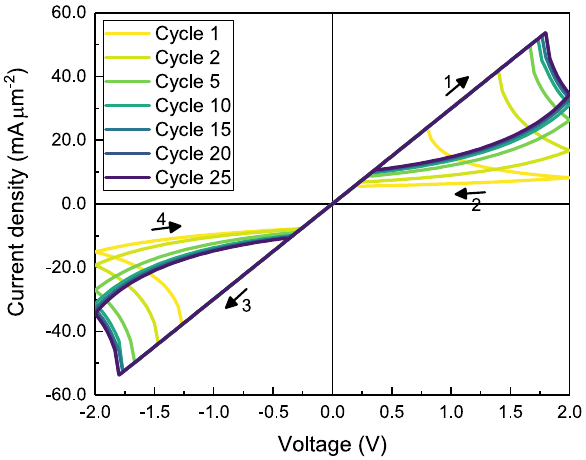
Figure 6. I–V curve for a 1D-simulation with high voltage. The diffusion coefficient for the oxygen ions is D O 2 − = 1 × 10 − 21 m 2 s − 1 and the voltage is V max = 2 V. All other parameters are listed in Table